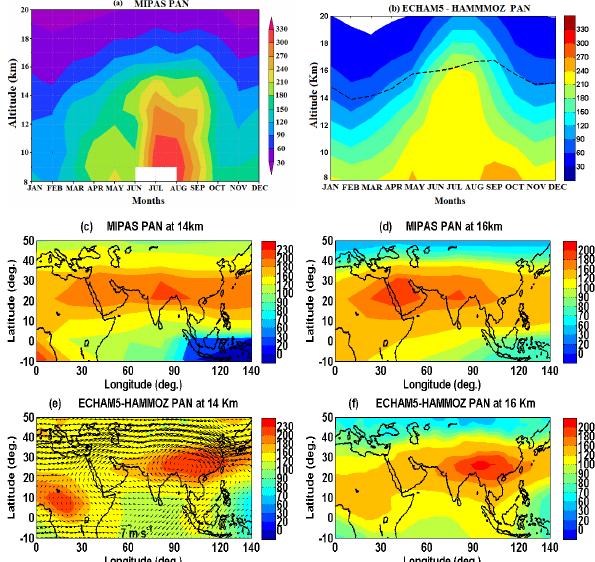
Figure 2. The monthly distribution of PAN (ppt) averaged over the anticyclone region (60–120 ◦ E, 10–40 ◦ N) (a) as observed by MIPAS and for the period 2002-2011 (b) ECHAM5-HAMMOZ reference simulation. Distribution of seasonal mean PAN concentration (ppt) as observed by MIPAS (climatology for the period 2002-2011) at (c) 14 km (d) 16 km and ECHAM5-HAMMOZ reference simulation at (e)14 km (f) 16 km. ECHAM5-HAMMOZ simulation is smoothed with averaging kernel of MIPAS.